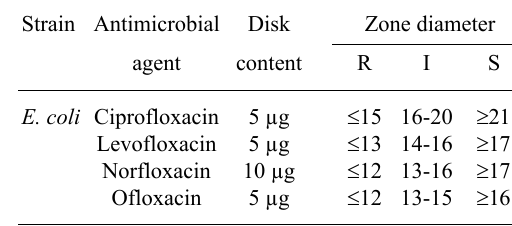
table 3. Interpretation of sensitivity testing